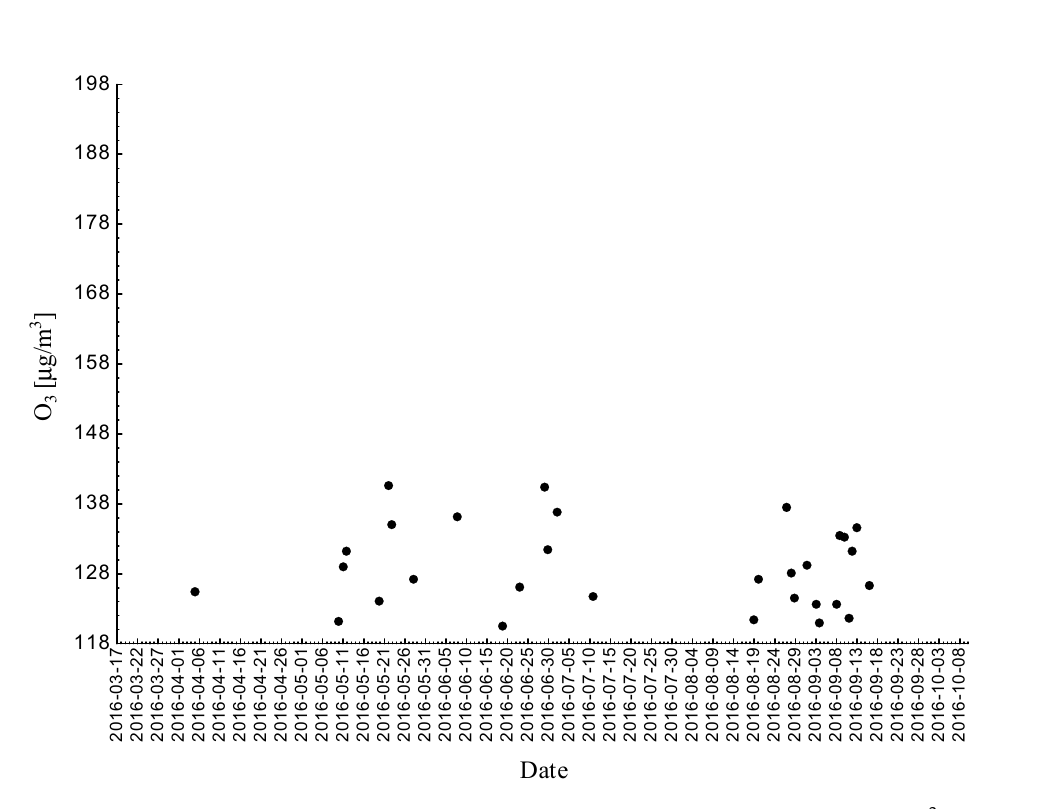
Figure 9. Maximum daily 8-h mean ozone concentration not less (equal to or more than) than 120.4 µg/m 3 registered at the measurement station in Zloty Potok SL03ZP in 2016.